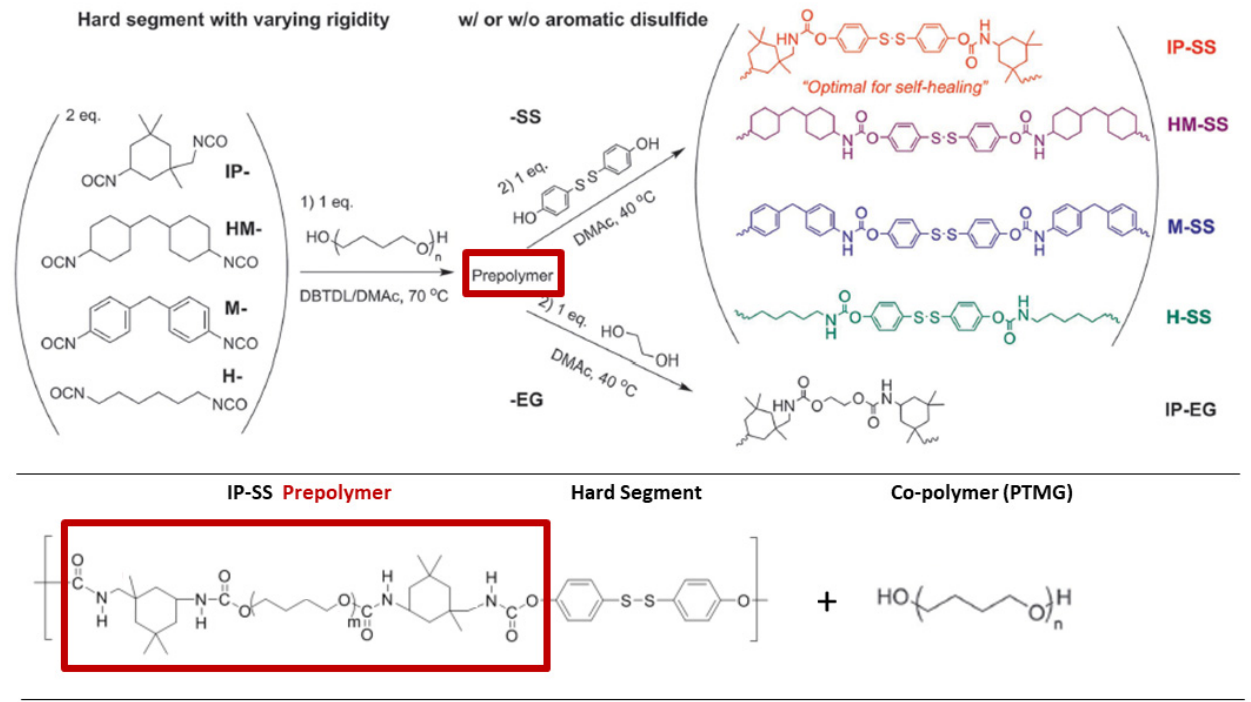
Figure 35. Synthesis of diphenyl disulfide “hard segment” prepolymers and subsequent copolymerization with PTMG. Adapted with permission from [13]. Copyright (2017) Wiley Periodicals, Inc.